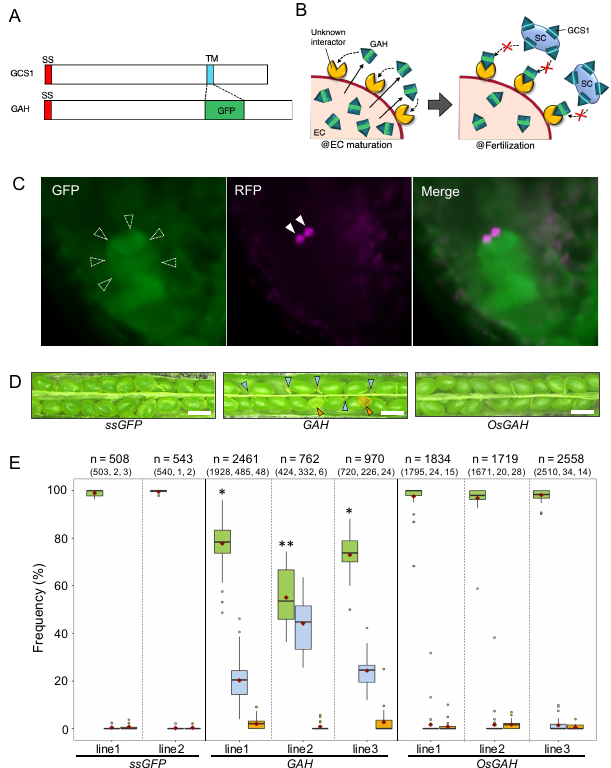
Figure 3. Artificial GAH synthesis in the egg cell blocked fertilization with the normal sperm cells. ( A , B ) Pictures are modified from Mori (2014) [30]. ( A ) Schematic view of the GAH construct. The original transmembrane region is replaced with GFP in GAH. SS: signal sequence; TM: transmem- brane region. ( B ) The scheme of this analysis. Left: During egg cell maturation, synthesized GAH is secreted from the cell due to the lack of a transmembrane region. The secreted GAH binds to the unknown interactor resident on the cell surface during egg cell maturation. Right: The sperm cells are released from a pollen tube into an embryo sac. GCS1/HAP2 is distributed to the sperm cell surface; however, the male and female gamete membrane fusion does not progress because the GCS1/HAP2 interactor can no longer bind to wild-type GCS1/HAP2. The following fusion process is arrested. SC: sperm cell; EC: egg cell. ( C ) GFP, RFP, and the merged images of an embryo sac from a self-pollinated GAH plant. GFP signal derived from the synthesized GAH was detected at the position of the egg cell (dashed arrowheads, left panel). Two magenta signals (triangles, middle panel) are the sperm cell nuclei visualized with HTR10mRFP, indicating that a pair of sperm cells were arrested without fertilization. ( D ) Seed development observed in ssGFP , GAH , OsGAH plants. Undeveloped and aborted seeds are marked with pale blue and orange triangles, respectively. Non-labeled green seeds are the normal development phenotype. Bar = 0.5 mm. ( E ) Frequencies of each seed development phenotype observed in the ssGFP , GAH , and OsGAH lines. The total number of the counted seeds in each plant line is indicated at the top of the column. The horizontal bar and a violet diamond on each box represent the median and the mean, respectively. The dots associated with each boxplot represent the outliers in the counted data. The different number of asterisks indicates the significant differences relative to the HTR10mRFP plant (Figure 1A) according to the Wilcoxon rank-sum test ( p <